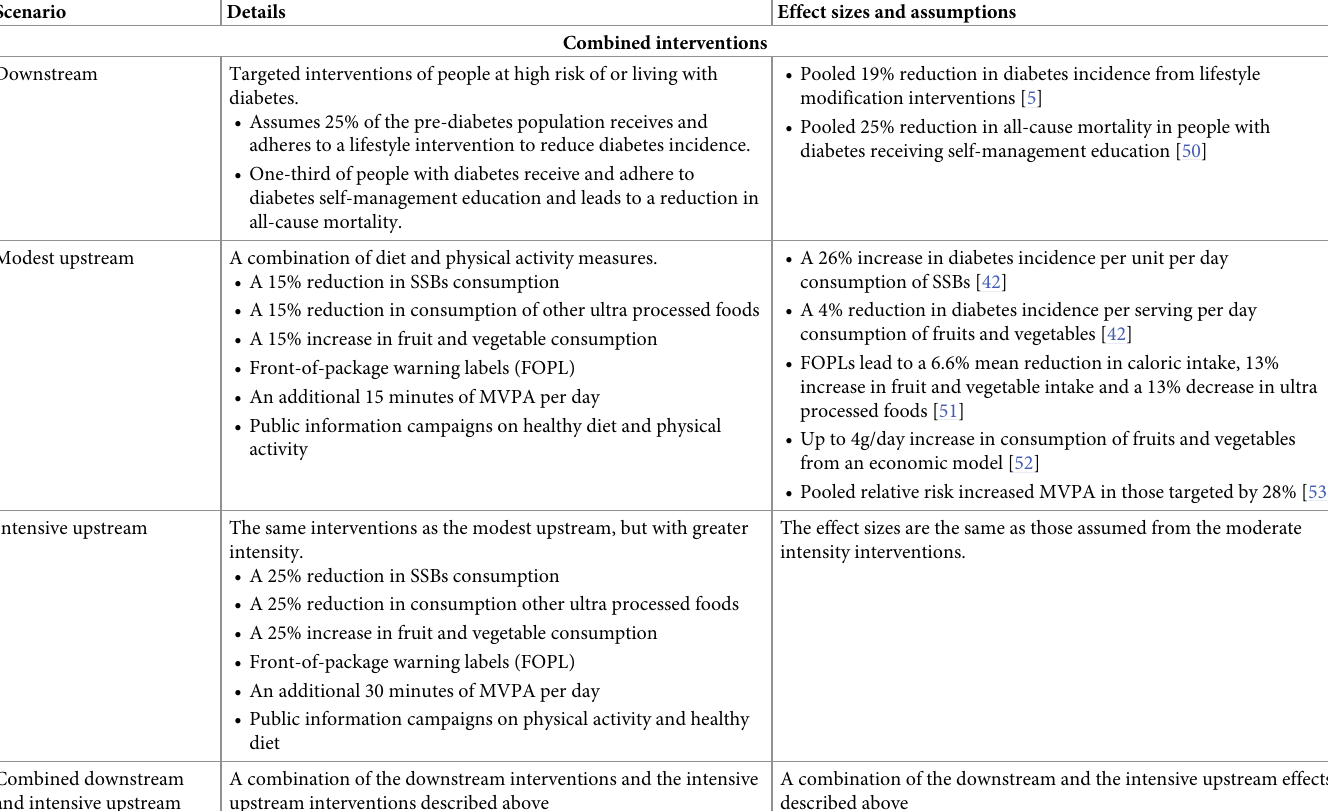
Table 2. Combined and individual model scenarios for decreasing diabetes and obesity prevalence in adults.